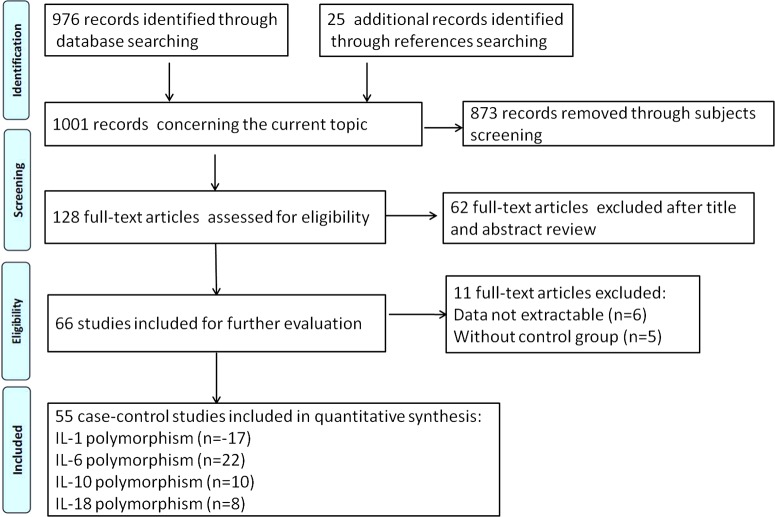
Flow chart of selection process in this meta-analysis